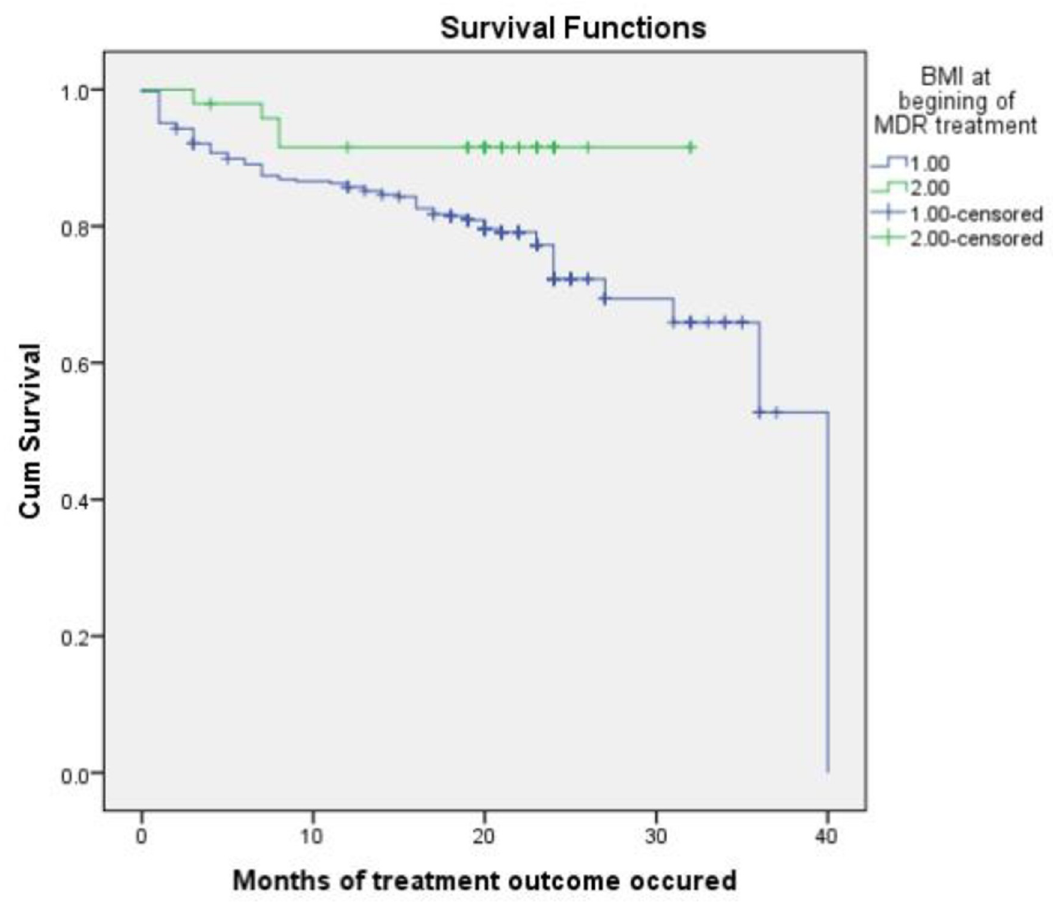
Fig 4. Kaplan–Meier probability of survival curve for BMI = < 18 and > 18 MDR-TB patients at Oromia hospitals, Oromia